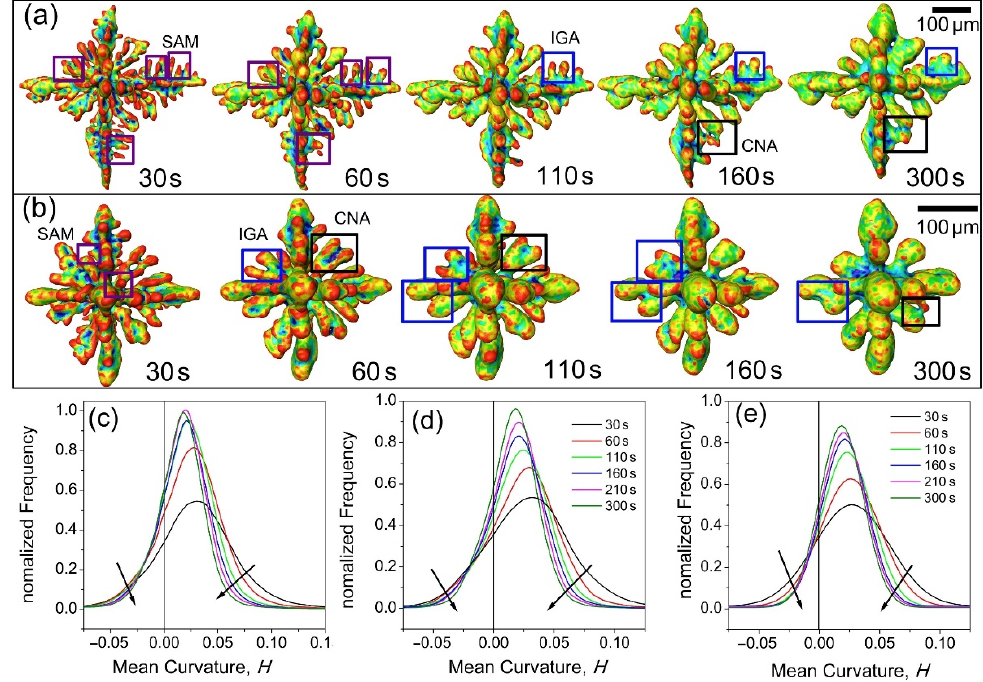
Figure 5. ( a ) The evolution of morphology and curvature for dendrite D1 and ( b ) those for D2. Different coarsening mechanisms were found at different stages of growth (marked with squares), and they are small arm melting (SAM), interdendritic groove advancement (IGA), and coalescence between neighboring arms (CNA), respectively. Video S2 and Video S3 show more clearly the dynamic evolution process. ( c ) The surface area (normalized frequency) as a function of curvature for all dendrites shown in Figure 4, and that for dendrite D1 ( d ) and D2 ( e ).